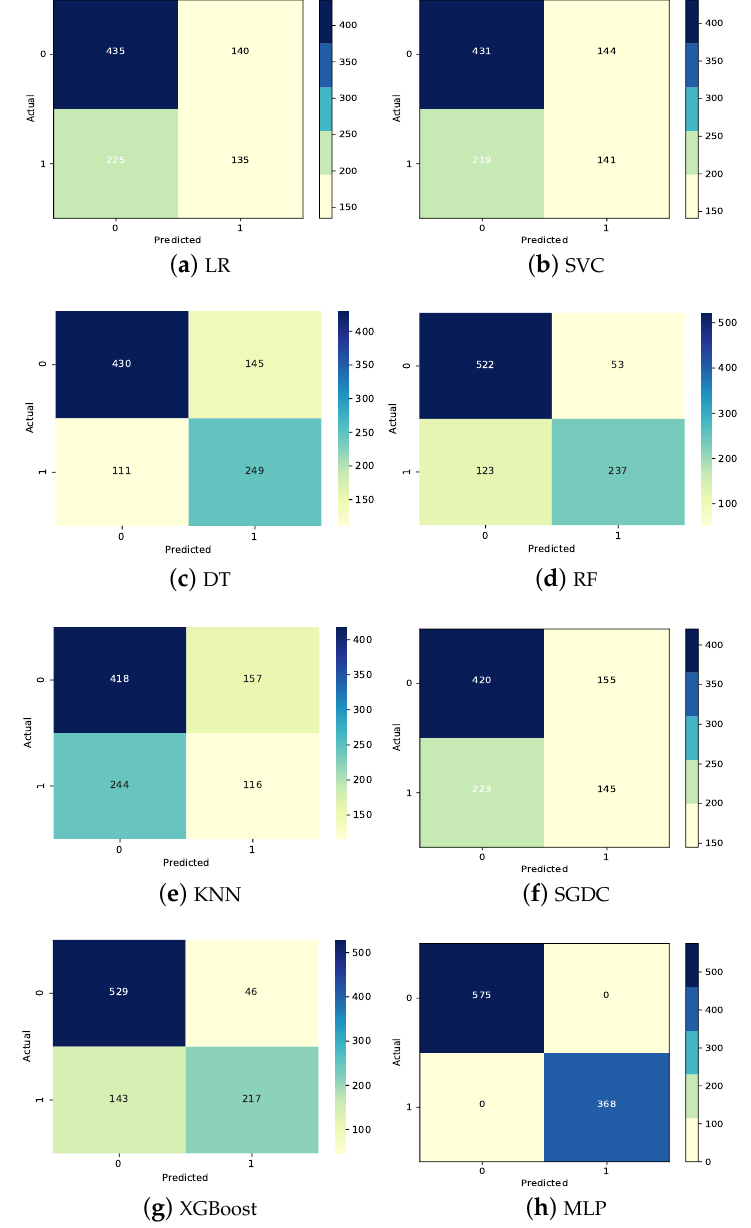
Figure 6. Confusion matrix of machine learning